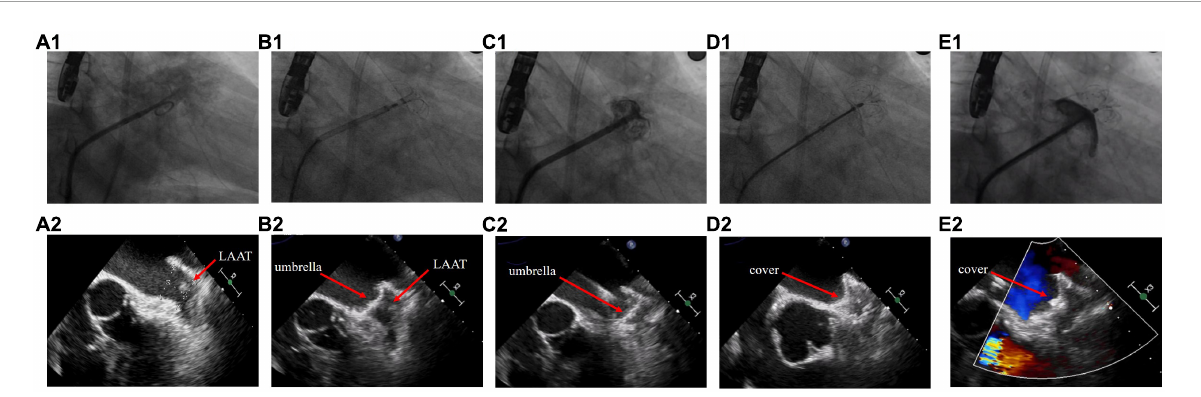
FIGURE1 Left atrial appendage closure strategy in patients with left atrial appendage thrombus. (A) Fluoroscopy and transesophageal echocardiography images before the procedure. (B) The umbrella of the LAmbre device was partially deployed at the ostium of left atrial appendage (LAA). (C) The umbrella was propelled distally to the LAA and expanded. (D) The cover was deployed to seal the LAA ostium. (E) Detection of peridevice leak.